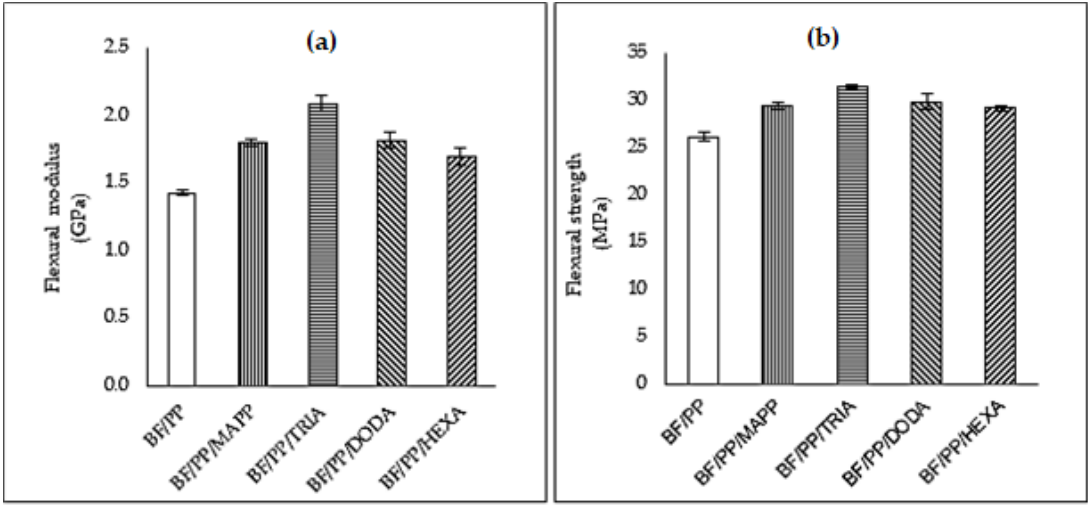
Figure 4. Results of the flexural test of the composites without CA and with CA: ( a ) modulus and ( b ) flexural strength.